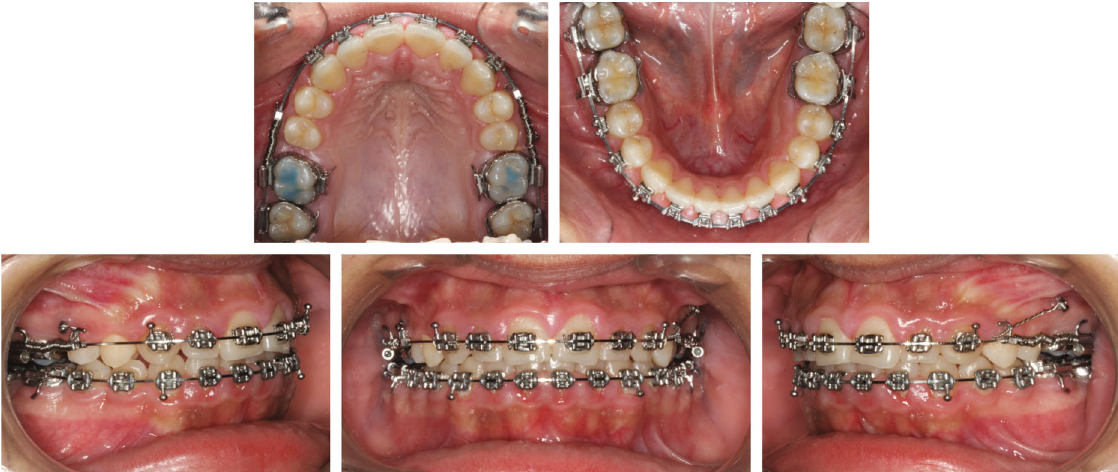
Figure 8: Case 1. Simultaneous distalization of maxillary fi rst and second molars, a space mesial to the maxillary right fi rst molar was noticed.